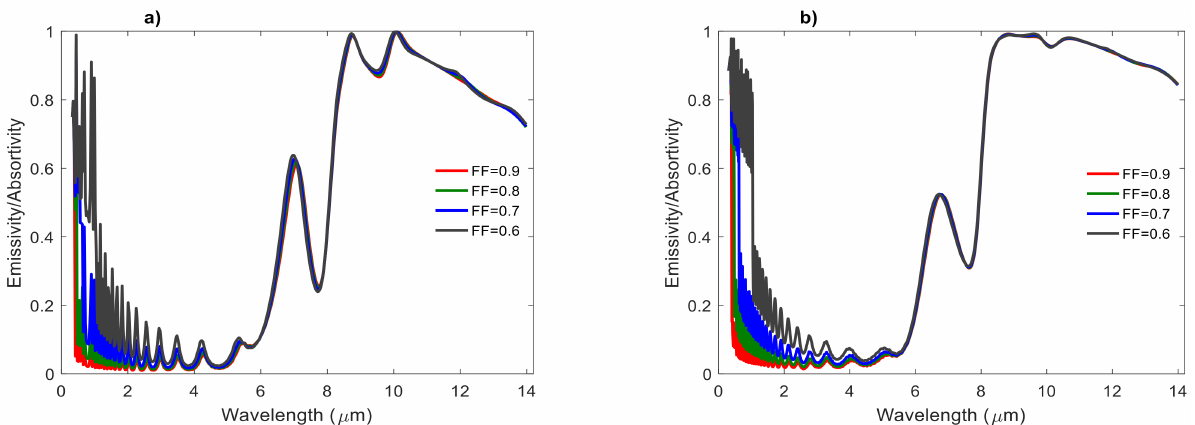
Figure 5. Effect of filling ratios for a double-layer selective emitter: ( a ) Spectral averaged emissivity at filling ratio from 0.6 to 0.9 of Ni-Al 2 O 3 with a filling ratio (FF = 0.8) of TiO 2 -SiO 2 . ( a ) Left-hand side of column indicates a normal incidence ( b ) and right-hand side of column indicates an oblique